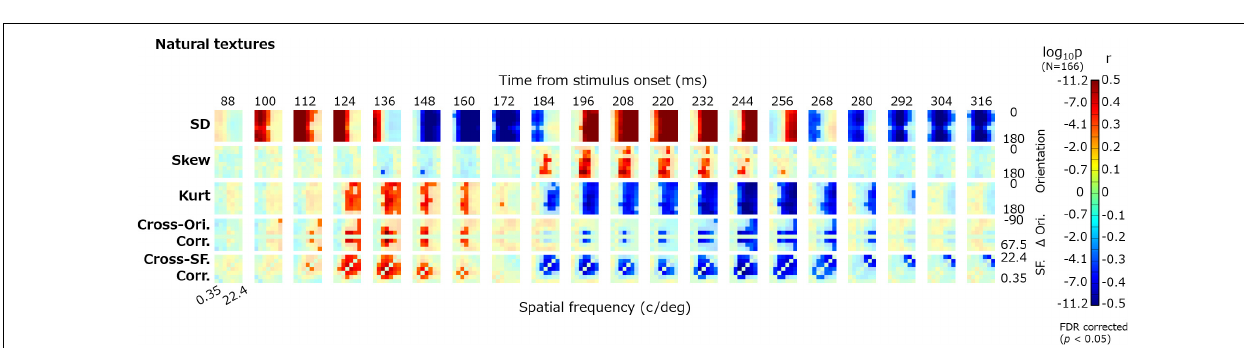
FIGURE 4 | Correlations between image statistics and VEPs. The rows from top to bottom show the correlation of VEPs with the log SD, skew, log kurtosis, cross-orientation correlation, and cross-frequency correlation. Red indicates positive correlations and blue indicates negative correlations. The colors are desaturated for values that are not statistically significant ( p ≥ 0.05, FDR corrected). The format of each panel follows that in Figure 2 . The maps are arranged in columns for different time points, from 88 to 316 ms. SF, spatial frequency; Ori, orientation; and r , correlation